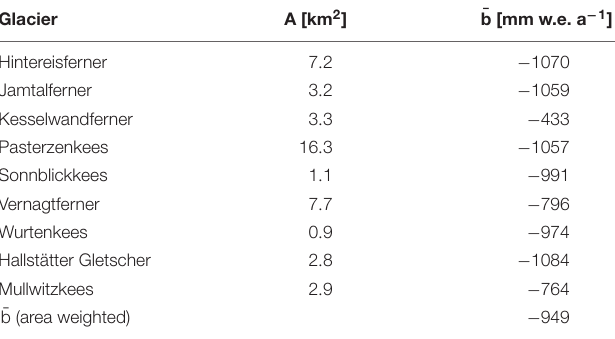
( Table 1 ). Between GI 1 and GI 3, the maximum ice flux modeled along the glacier (i.e., ice flux at the apparent equilibrium